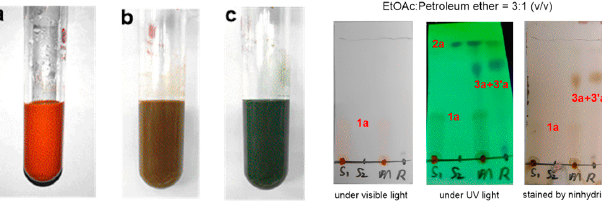
Figure 2. The phenomenon of the reaction for 1a and 2a under K 2 CO 3 in DCE at reflux and TLC analysis: ( a ) no K 2 CO 3 (0 h) (a light red cloudy solution); ( b ) added K 2 CO 3 (3 h) (a clarified luminous yellow solution); ( c ): reaction finished (4 h) (a dark green solution).